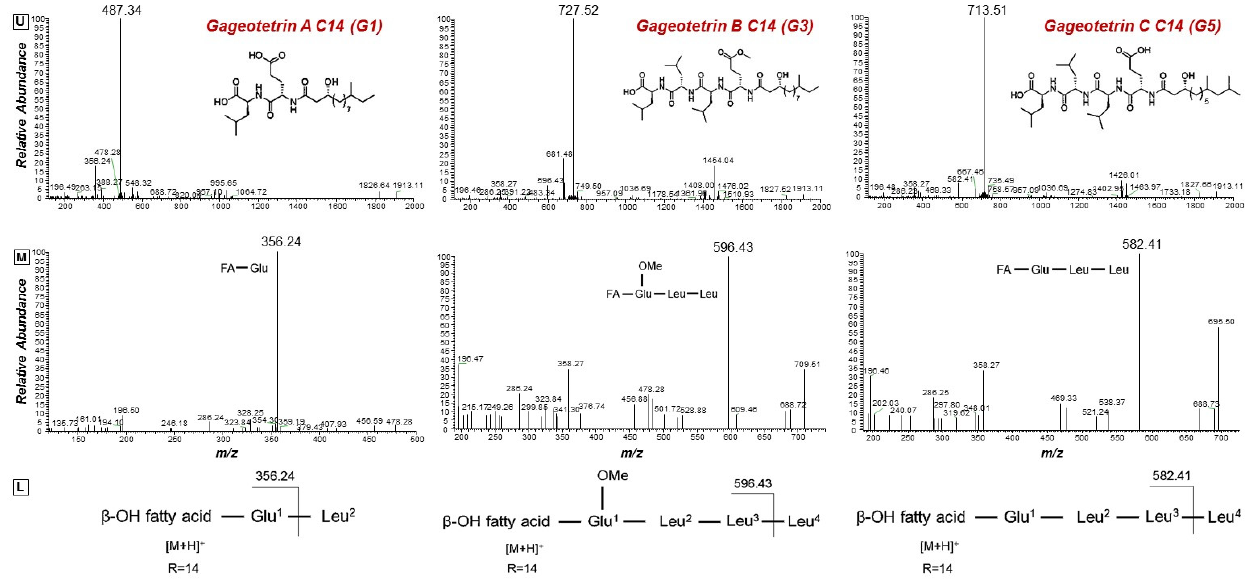
Figure 4. MS 1 ( upper plots; U ) and MS 2 ( middle plots; M ) of the Bacillus sp. PTA13 LP Gageotetrins A–C. The fragmentation patterns were used for the annotation of the LP ( lower plots; L ).